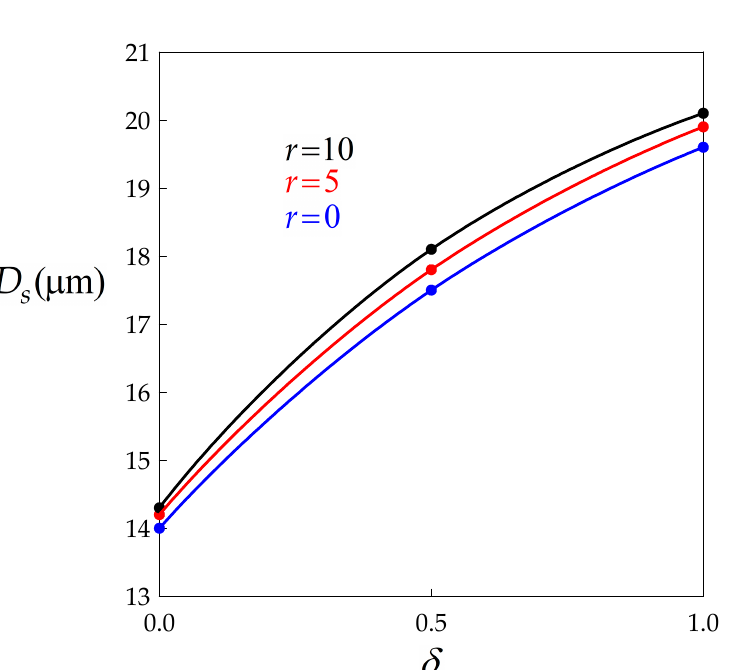
Figure 5. Diagram showing the dependence of the steady state grain size on the BMIS parameter for three values of the recovery coefficient r . Data points are connected by spline curves. Table 2. Numerical values of parameters